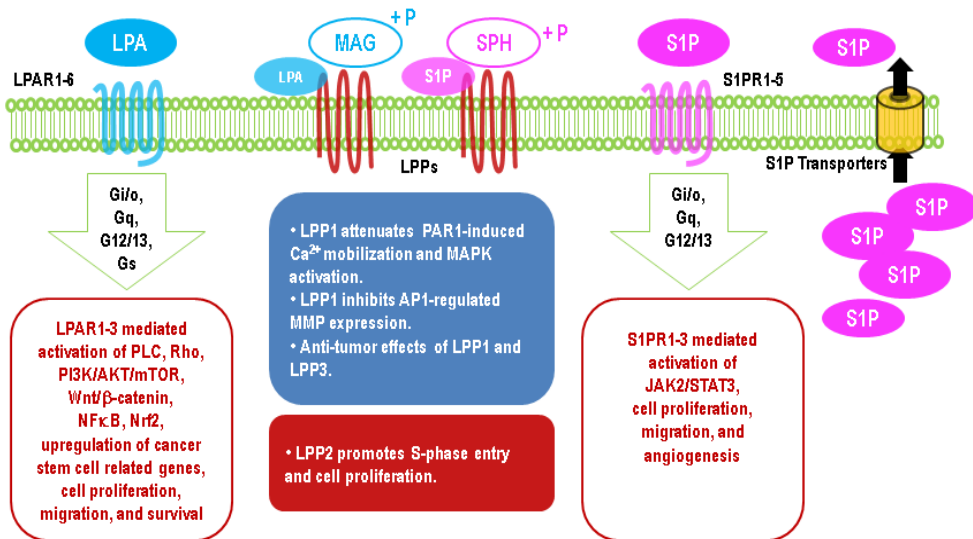
Figure 3. Major effects of upregulation of lysophosphatidate (LPA) and sphingosine 1-phosphate (S1P) signaling in cancer cells through G protein-coupled receptors and different functions of LPP1/3 LPP2 in and LPP2 in cancers.